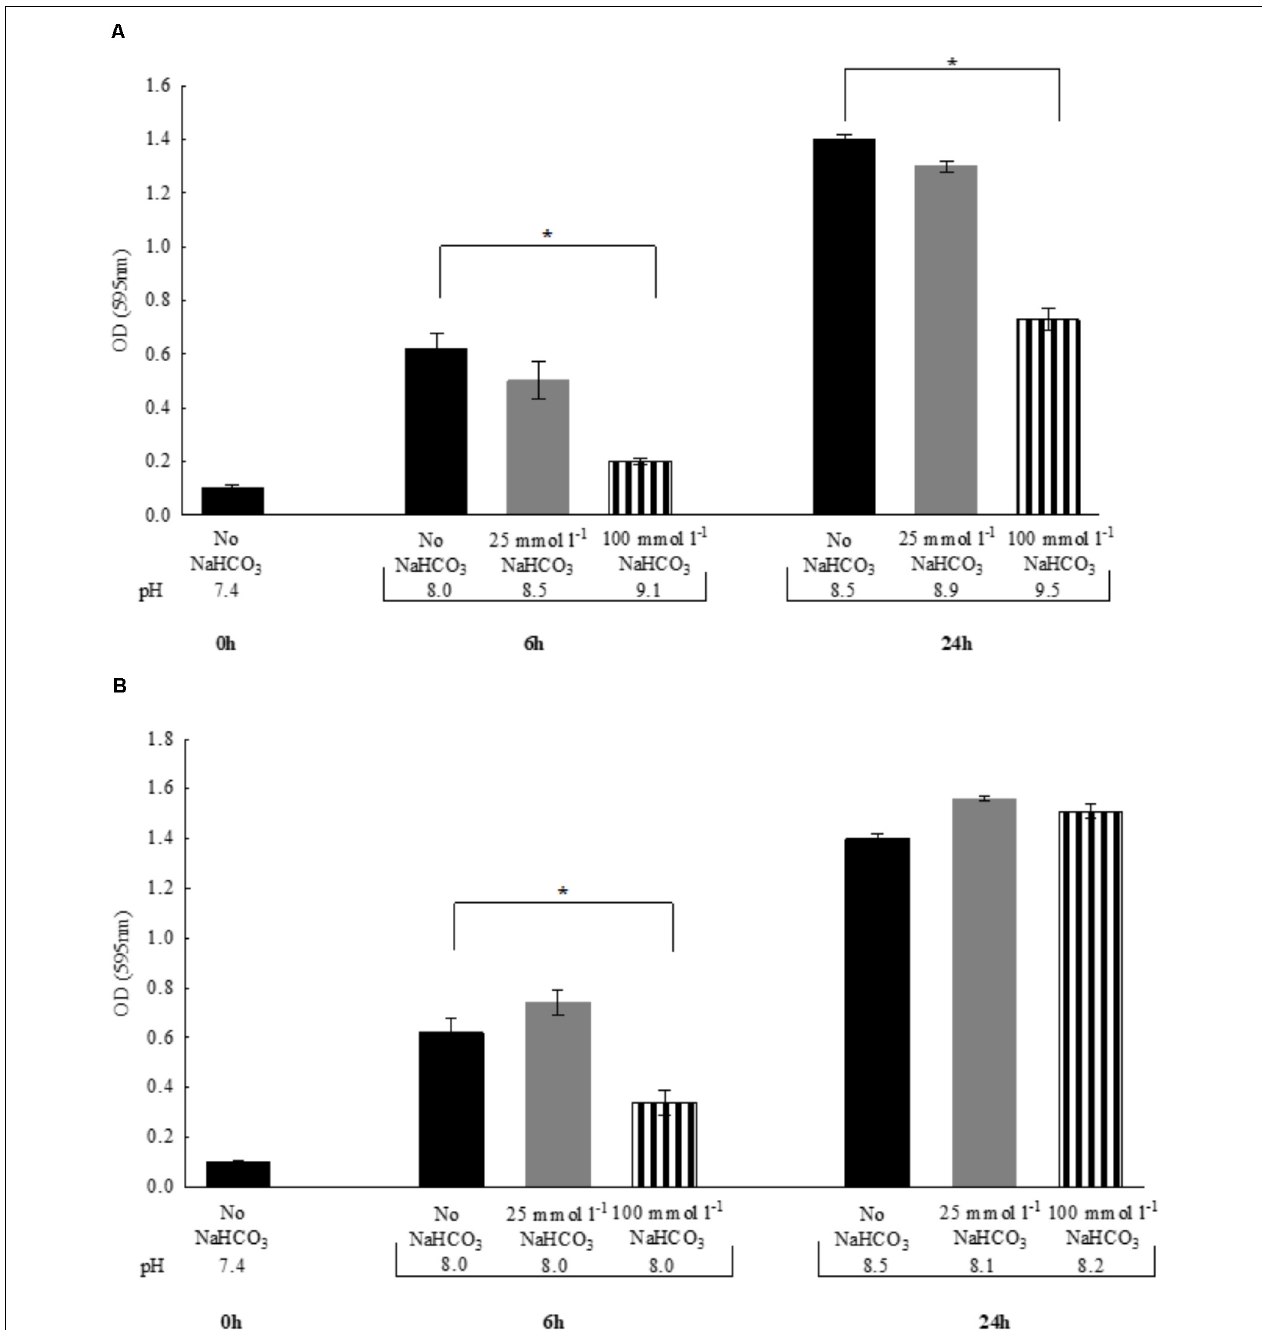
FIGURE 2 | Changes in bacterial density of Pseudomonas aeruginosa and media pH following 6 vs. 24 h incubations either (A) in air atmosphere, or (B) in the presence of appropriate levels of CO 2 . Black bars: NaHCO 3 -free controls, gray bars: 25 mmol l − 1 NaHCO 3 ; striped bars: 100 mmol l − 1 NaHCO 3 . Statistically significant, ∗ P <